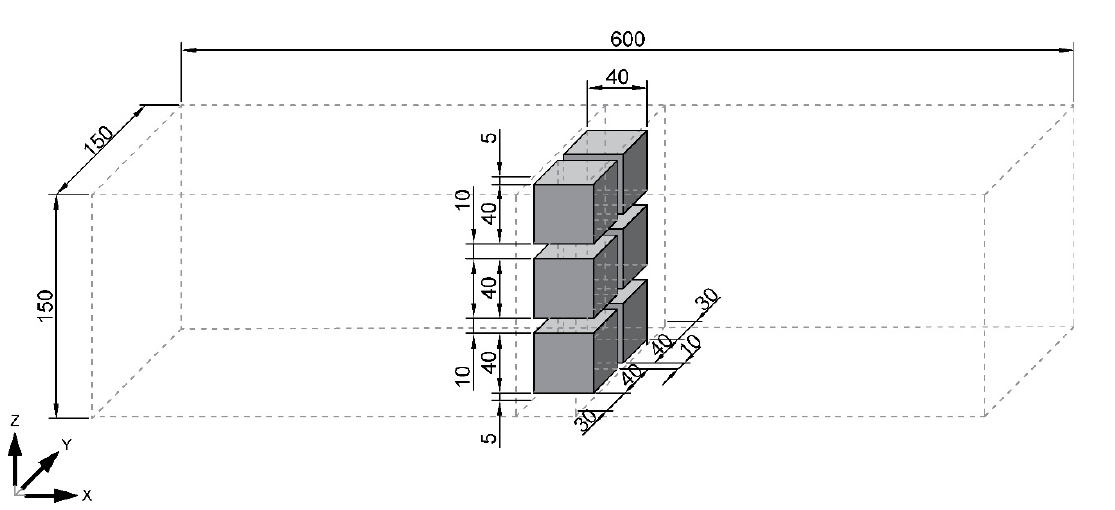
Table 1. Dosage of the concrete mix.